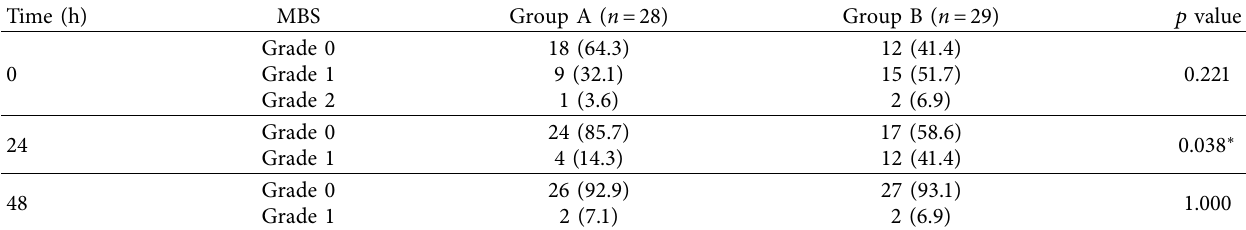
Table 3: Motor block scores using a modifed Bromage scale (MBS) analgesic at 0, 24, and 48h after the surgery.